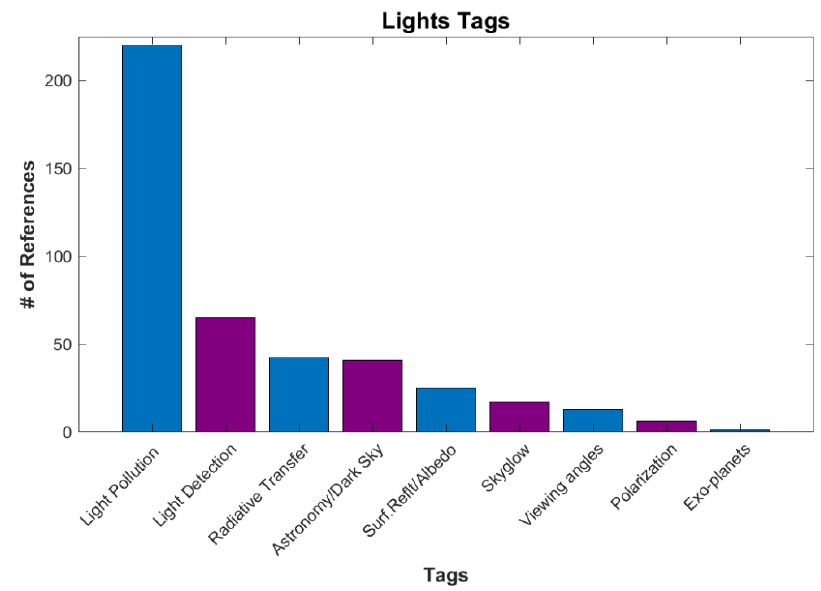
Figure 10. The number of references for various tags under